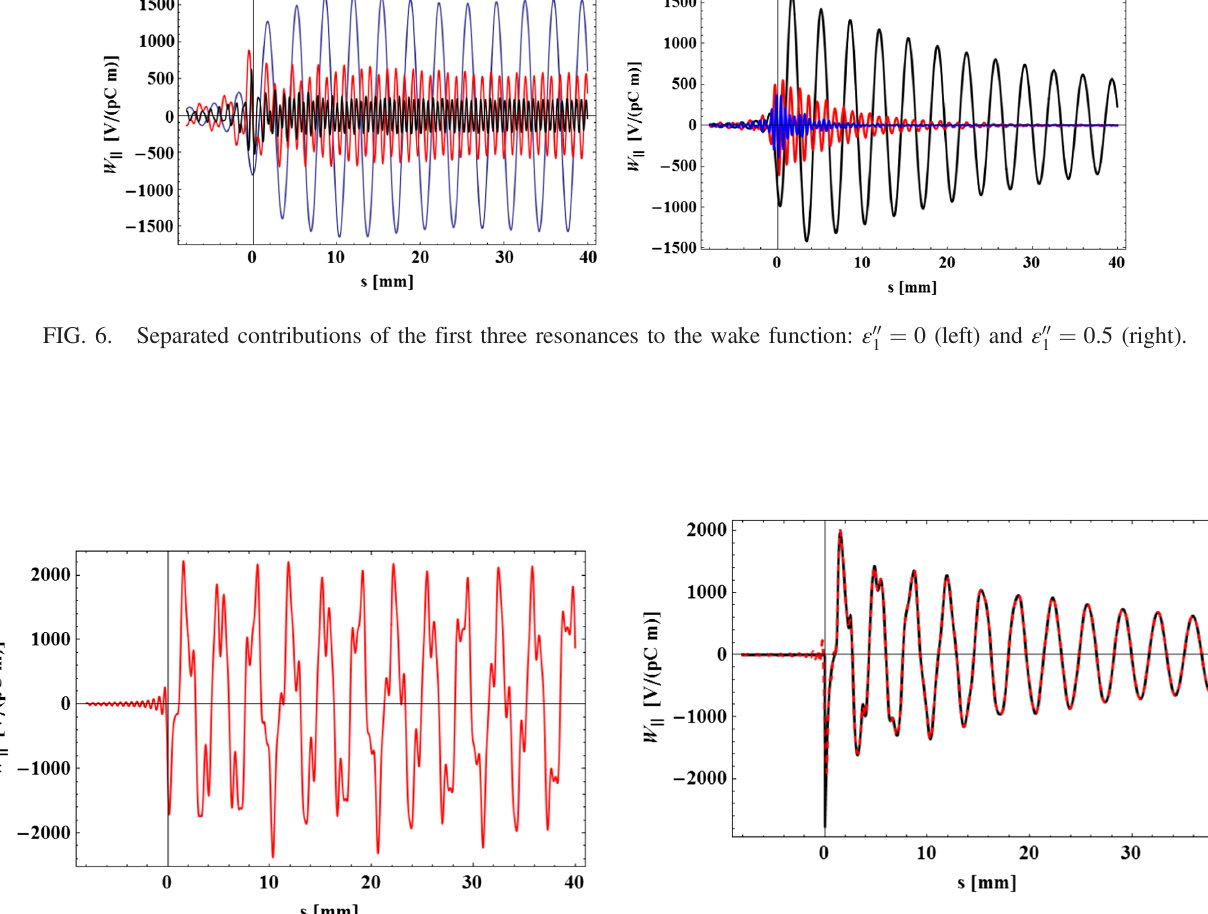
FIG. 7. The total contribution of the first three resonances to the wake function for ε 00 1 ¼ 0 .